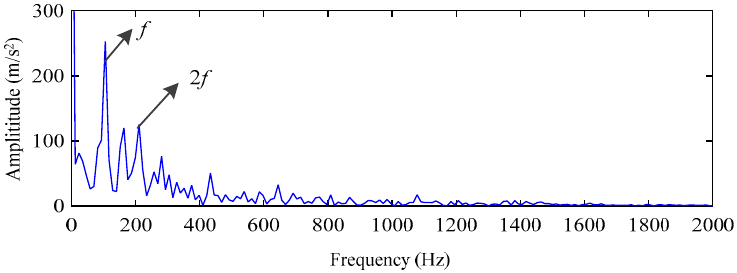
Figure 23. The envelope spectrum of the optimal component for outer ring defect by using EMD.